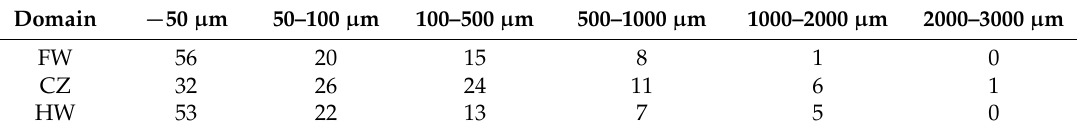
Table 13. Percentage gold particle distribution (by mass) for SVZ mineralisation